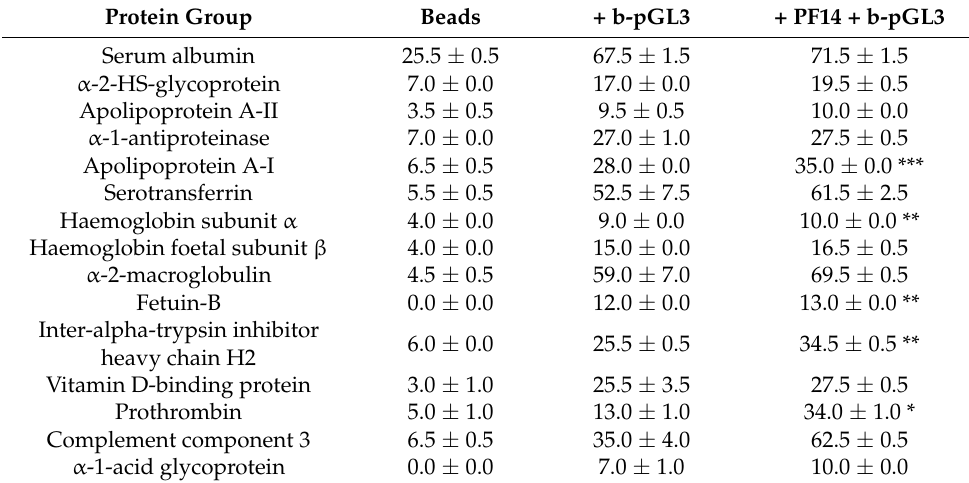
Table 3. Mass-spectrometry analysis of proteins bound to CPP-pDNA nanoparticles in bovine serum at higher level. PF14-pDNA nanoparticles or pDNA alone were coupled to streptavidin- coated superparamagnetic beads and incubated with bovine serum for 30 min at room temperature. After pull-down of beads with magnet and washes, the proteins of PC were digested with trypsin and analysed by mass-spectrometry. Overall number of identified peptides of a protein group is presented. Fifteen most abundant proteins in protein corona are listed. Data represents two independent experiments and three technical replicates of each with ± SEM, compared to b-pGL3.